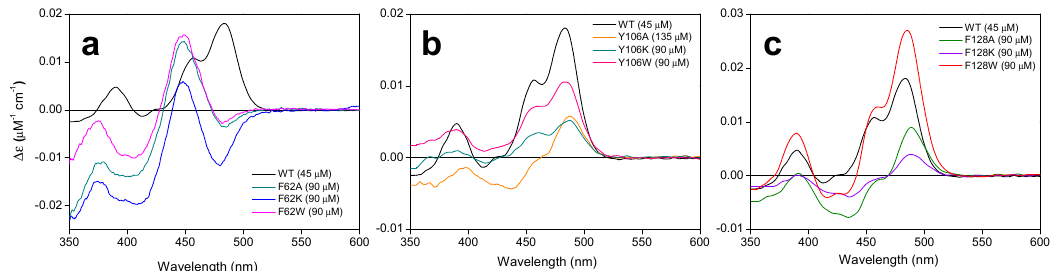
Figure 5. Internalization of the isoalloxazine ring of FMN in Ca FADS variants. Visible difference spectra elicited with ( a ) F62, ( b ) Y106, and ( c ) F128 Ca FADS variants (4–6 μ M) upon titration with saturating FMN concentrations (indicated in parenthesis for each variant). In all panels, the difference spectrum of WT is included for comparison. Spectra recorded in 20 mM PIPES, 10 mM MgCl 2 , pH 7.0 at 25 °C.